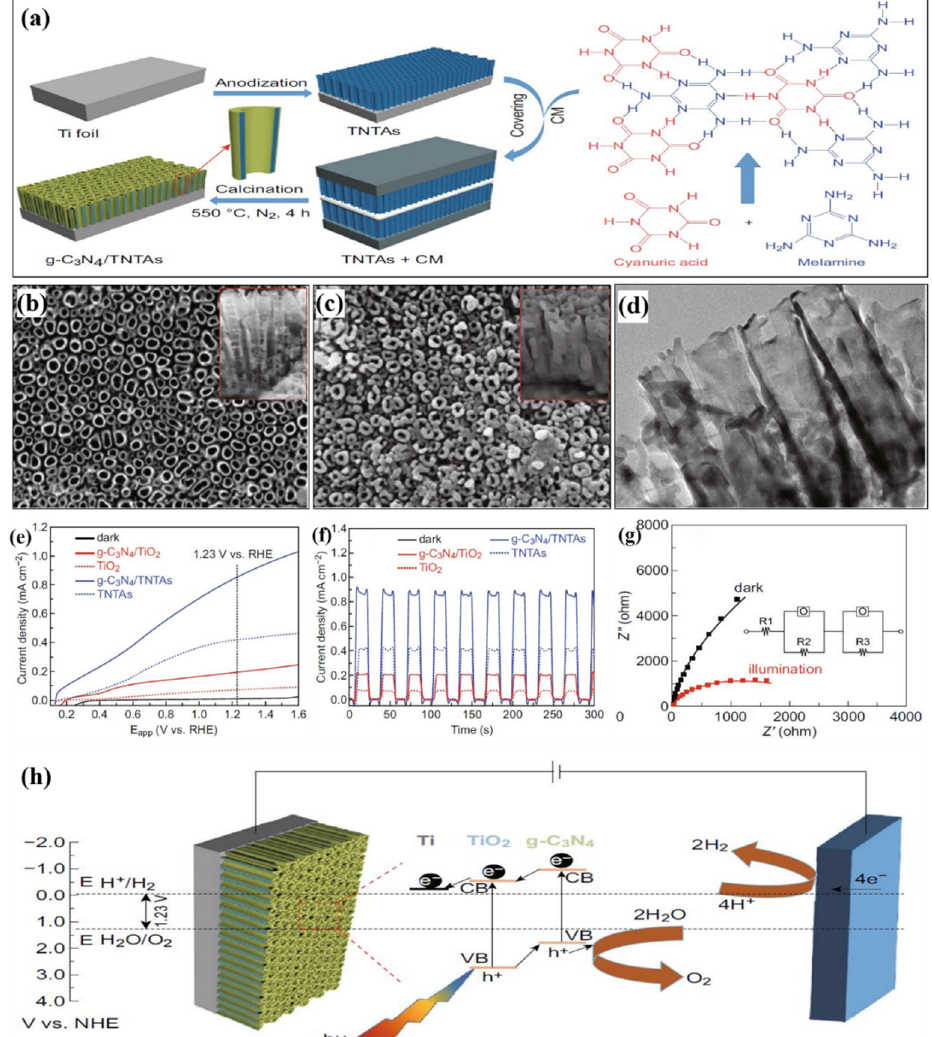
Figure 4. ( a ) Formation mechanism of CN-TN heterojunction, SEM images of ( b ) TNTAs, ( c ) CN-TN heterojunction, ( d ) TEM image of CN-TN heterojunction, ( e ) LSV curves, ( f ) I-t curves, ( g ) Nyquist plots, and ( h ) charge transfer mechanism of the CN-TN heterojunction. Reprinted with permission from reference [66], Copyright 2018, Springer.